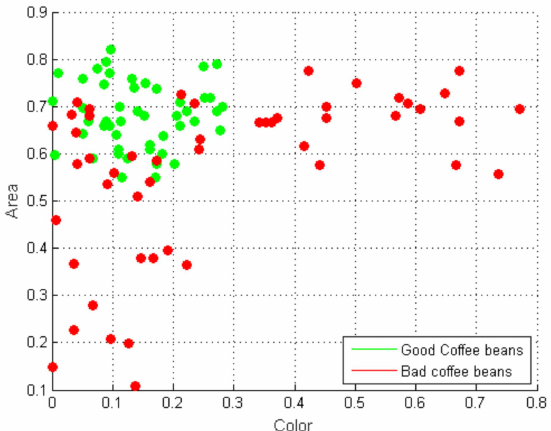
Figure 12. 2D plot of area and color features used for the k -nearest neighbor algorithm using the training